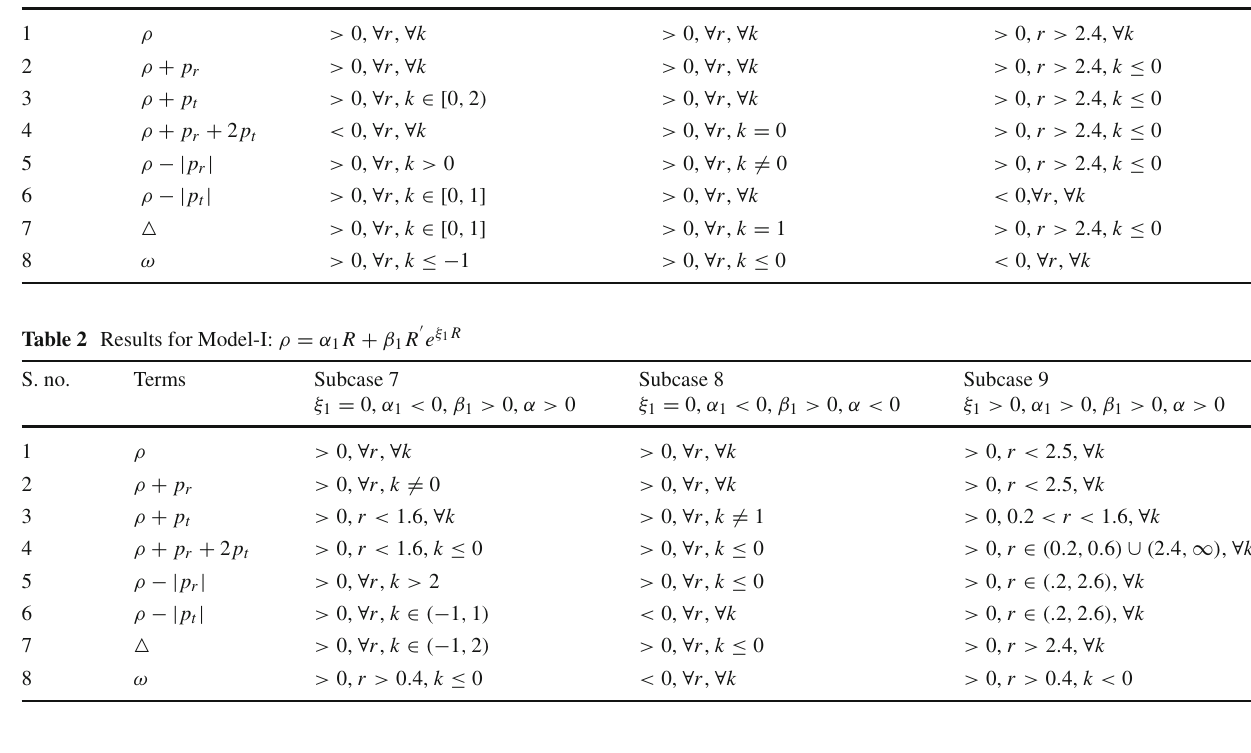
Table 1 Results for Model-I: ρ = α 1 R + β 1 R (cid:2) e ξ 1 R S. no.